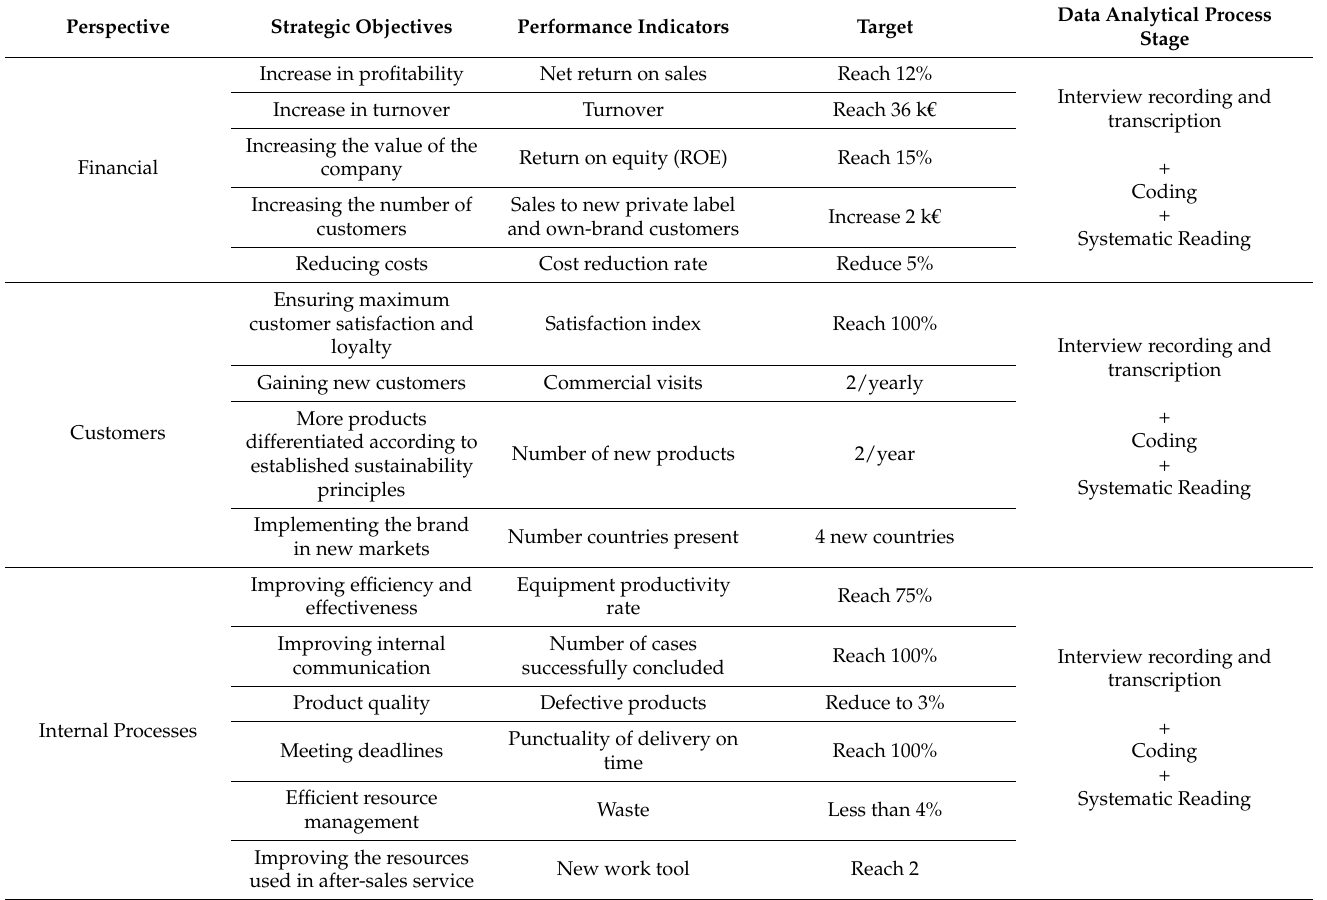
Table 2. Performance Indicators and